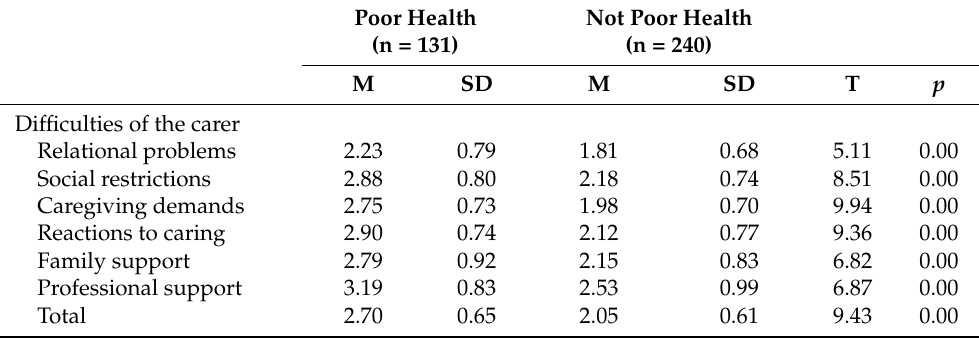
Table 10. Results of the study of caregiver difficulties as a function of health